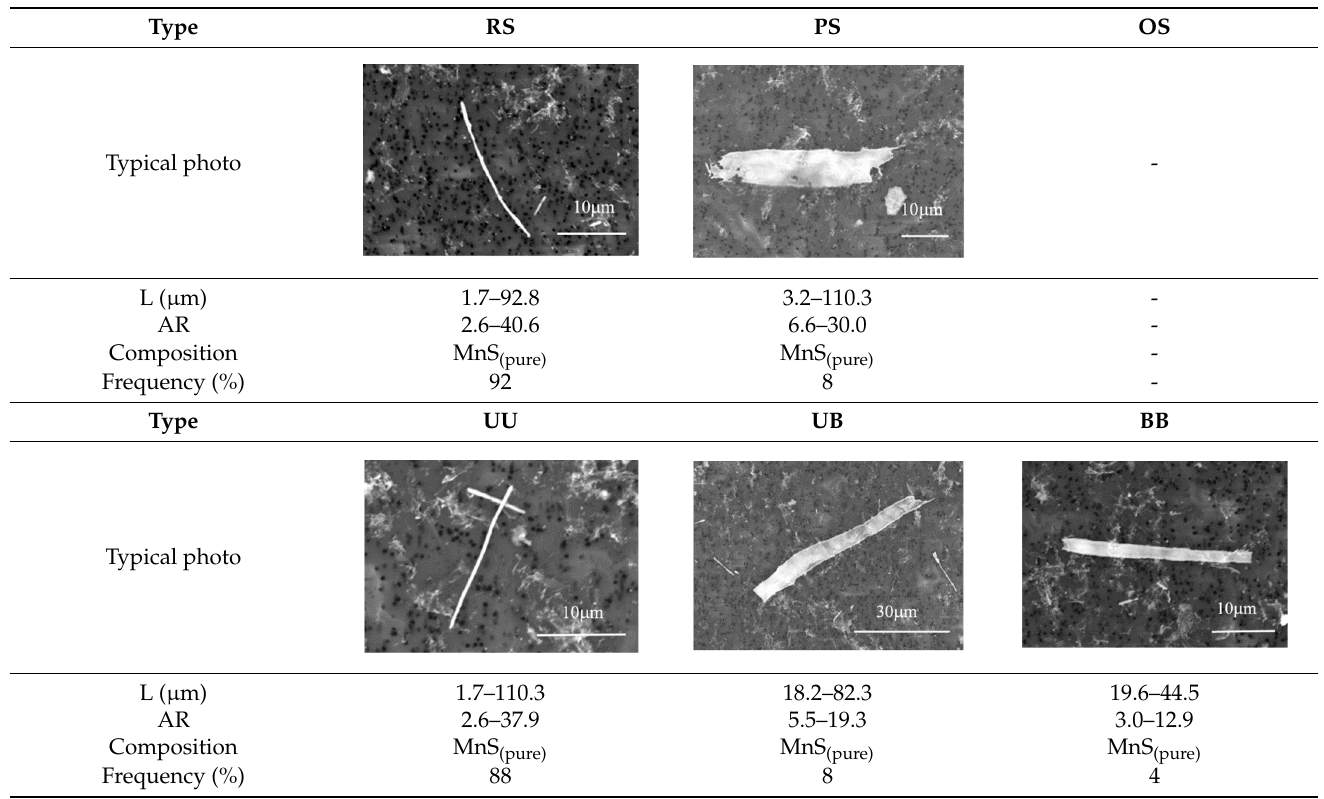
Table 12. The classification of different types of sulfide NMIs in the sample of 13HMF by using Method 2.